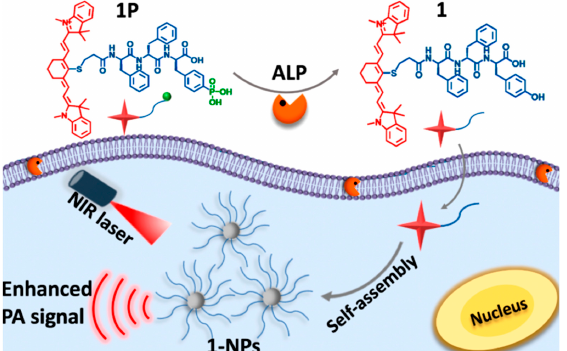
Figure 13. Schematic illustration of alkaline phosphatase (ALP)-triggered self-assembly of NIR nanoparticles from 1P (1) for the enhanced photoacoustic imaging of tumors. Reprinted with permission from [87]. Copyright, American Chemical Society (2018).